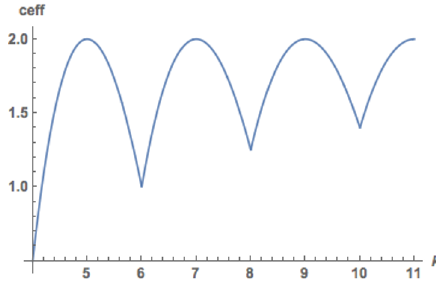
Figure 18 . The effective central charge as a function of k . For k an odd integer we have c eff = 2 , while for k an even integer we have c